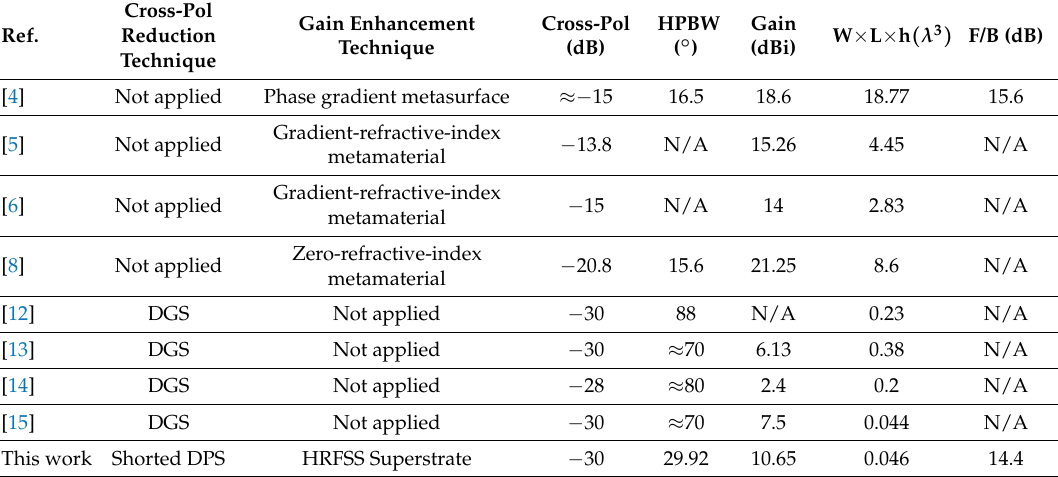
Table 3. Comparison of the proposed